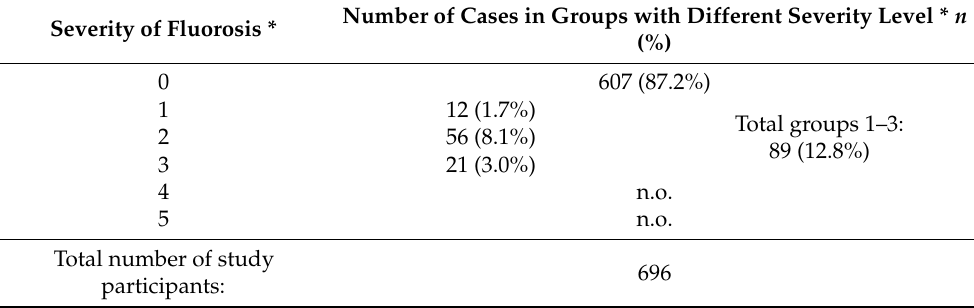
Table 1. The severity of fluorosis in the study group, according to Dean’s Index. Number of Cases in Groups with Different Severity Level * n Severity of Fluorosis * (%) 0 607 (87.2%) 12 (1.7%) Total groups 1–3: